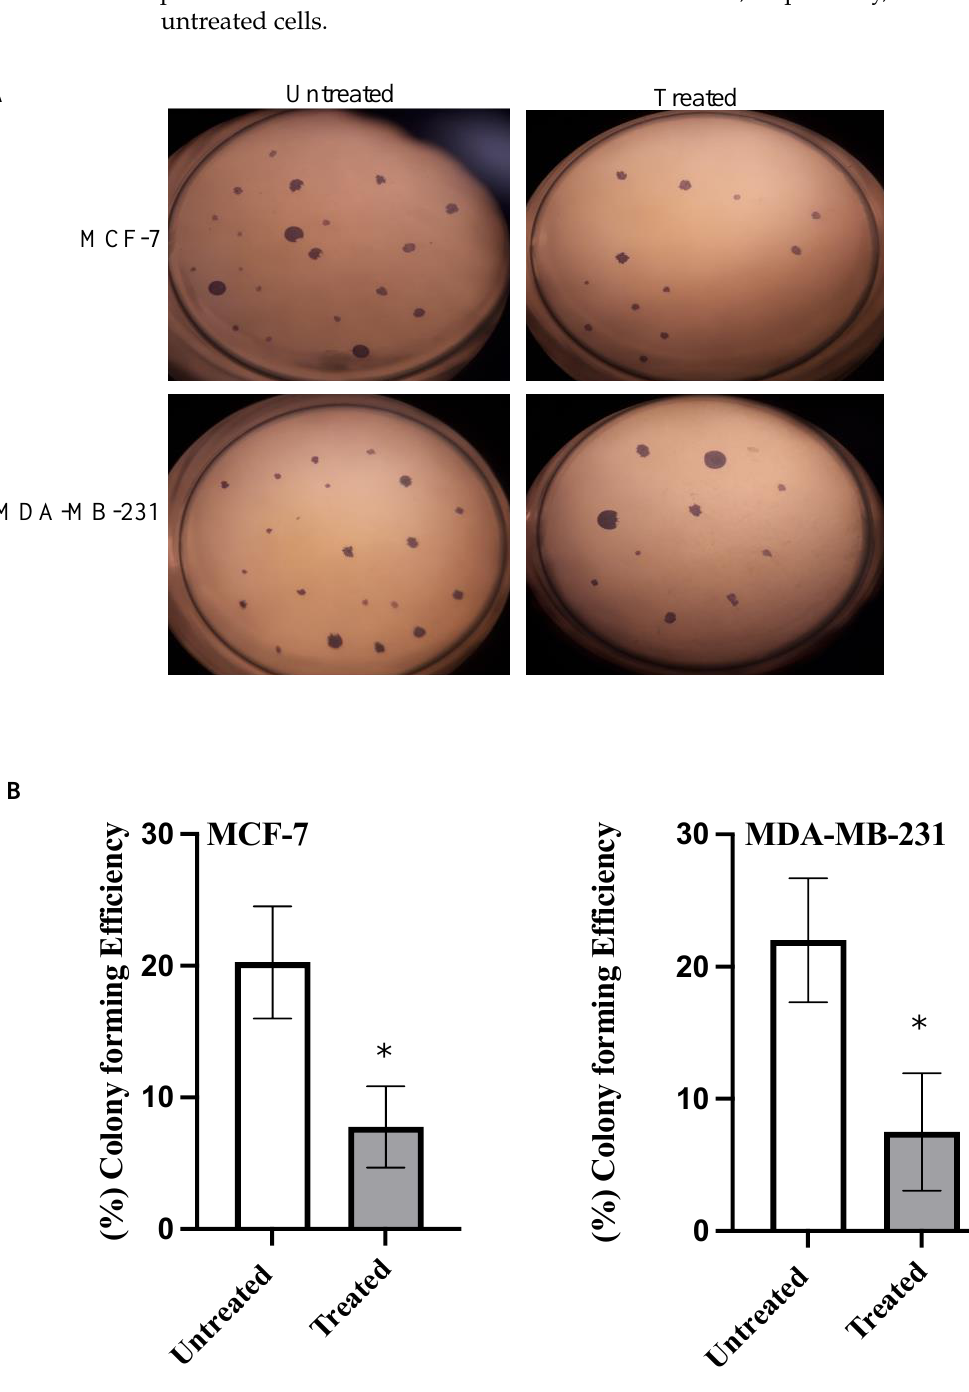
Figure 4. Effect of azilsartan on colony formation ability of MCF-7 and MDA-MB-231 breast cancer cell lines. ( A ) Representative images for the colonies formed before and after treatment with the IC 50 of azilsartan in MCF-7 and MDA-MB-231 cell lines. ( B ) The percentage of colony forming efficiency of both cancer cell lines. Bars represent mean ± SD, n = 3. Significant difference was analyzed using student t test, where * p < 0.05, compared to untreated cells.